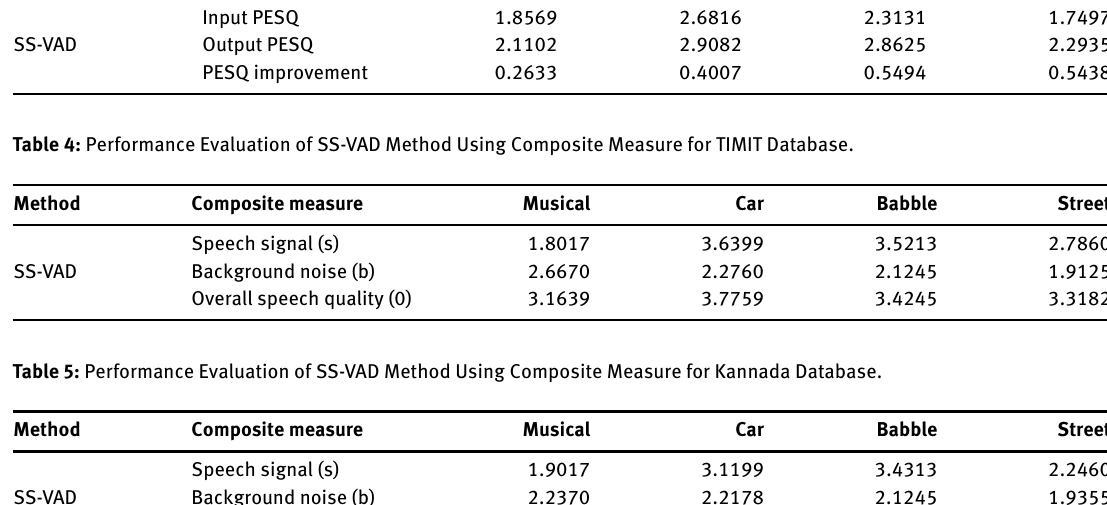
Table 3: Performance Measurement of SS-VAD Method in Terms of PESQ for Kannada Database. Method